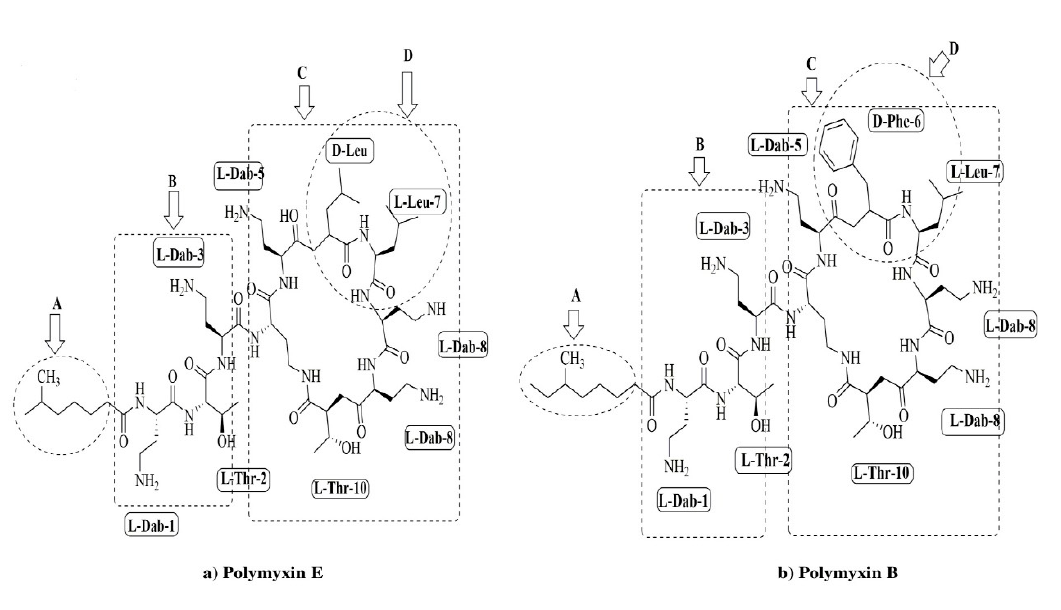
Figure 1. Chemical structures of polymyxin E (colistin) ( a ) and polymyxin B ( b ). The functional segments of polymyxins A: NR fatty acyl chain, B: linear tripeptide segment, C: the polar residues of the heptapeptide, D: the hydrophobic motif within the heptapeptide ring.